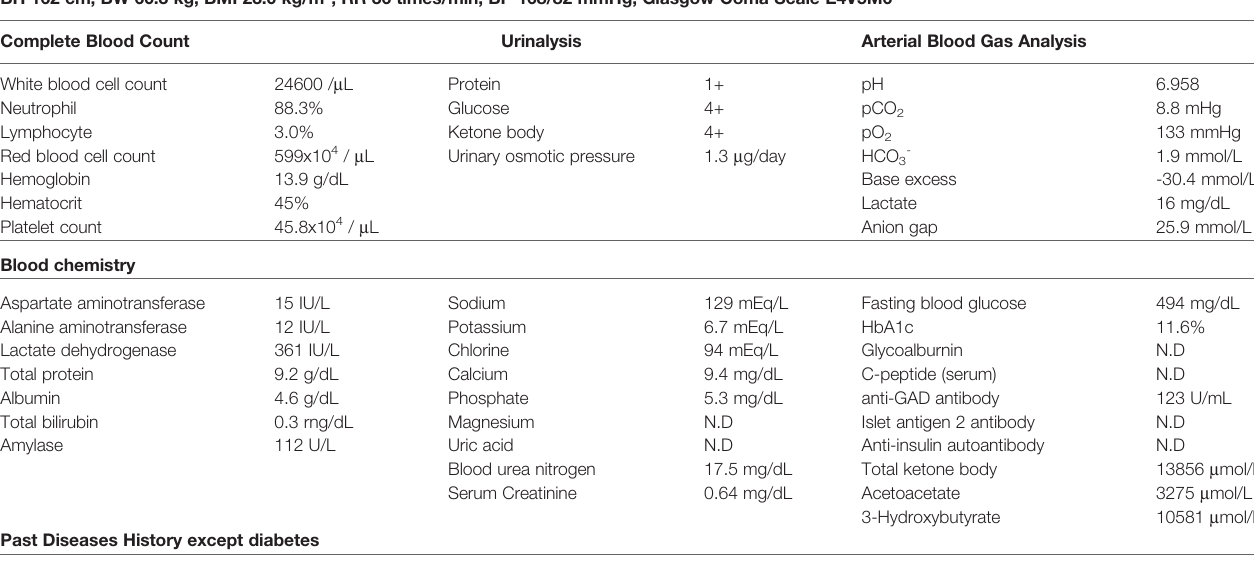
TABLE 2 | The patient's physical examinations and laboratory data on admission. Physical